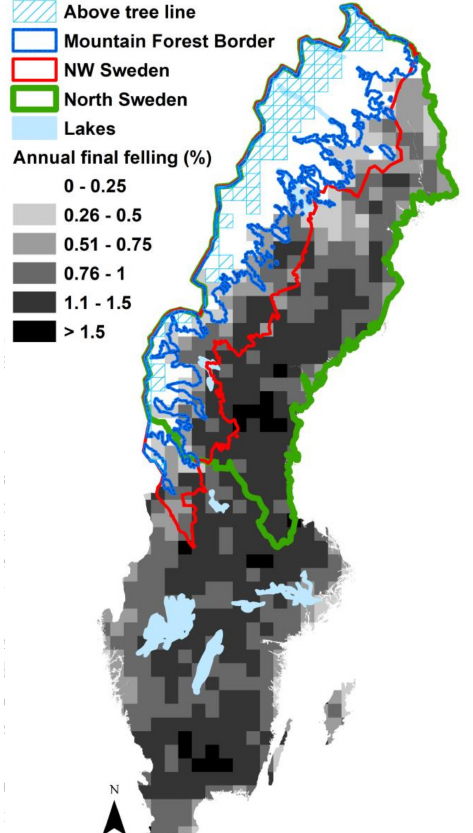
Figure 6. Mean annual forest loss [defined in reference [54] as proxy of the annual final felling rate in percent. Overall, 93% of forest loss is clear-felling and the rest to is linked to forest fire and windfall. A mean harvest rate of one percent corresponds to a 100 year rotation time in even-aged industrial forestry. The grid cell size is 25 × 25 km.